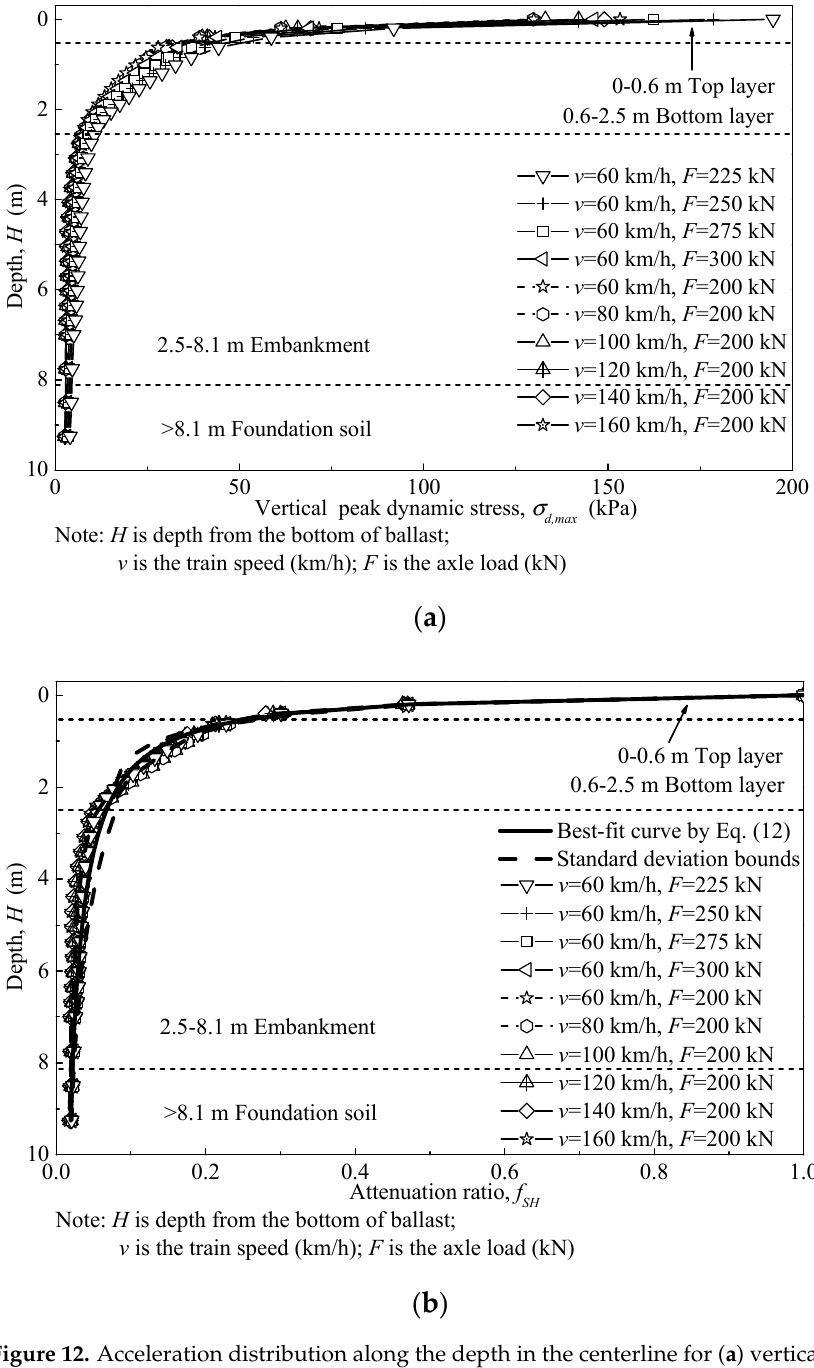
Figure 12. Acceleration distribution along the depth in the centerline for ( a ) vertical peak dynamic stress σ d, max and ( b ) attenuation ratio ( f SH ).